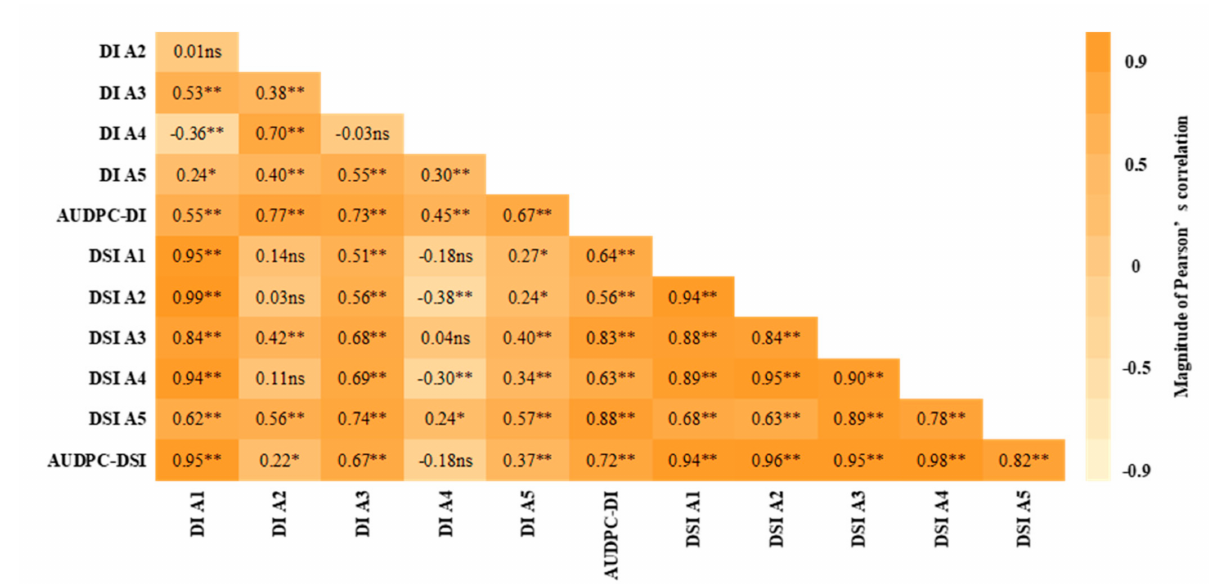
Figure 6. Triangular heat map representing Pearson correlation coefficients between disease incidence (DI), disease severity index (DSI), the area under the disease–progress curve of disease incidence (AUDPC-DI), and the area under the disease– progress curve of disease severity index (AUDPC-DSI) of 23 small-ear waxy corn varieties. A1= plant age 14 days after infected, A2 = plant age 21 days after infected, A3 = plant age 28 days after infected, A4 = plant age 35 days after infected, and A5 = plant age 42 days after infected. *, ** significant at p ≤ 0.05 and p ≤ 0.01,